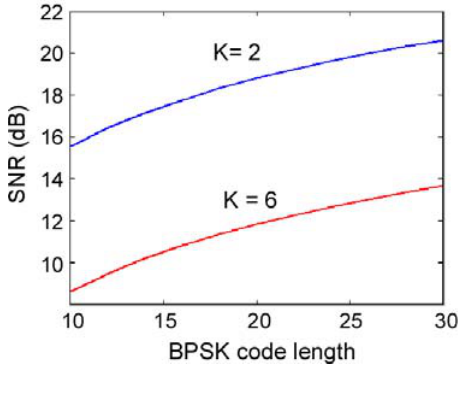
Figure 9. Calculated signal to noise ratio (SNR) for different binary phase-shift keying (BPSK) code